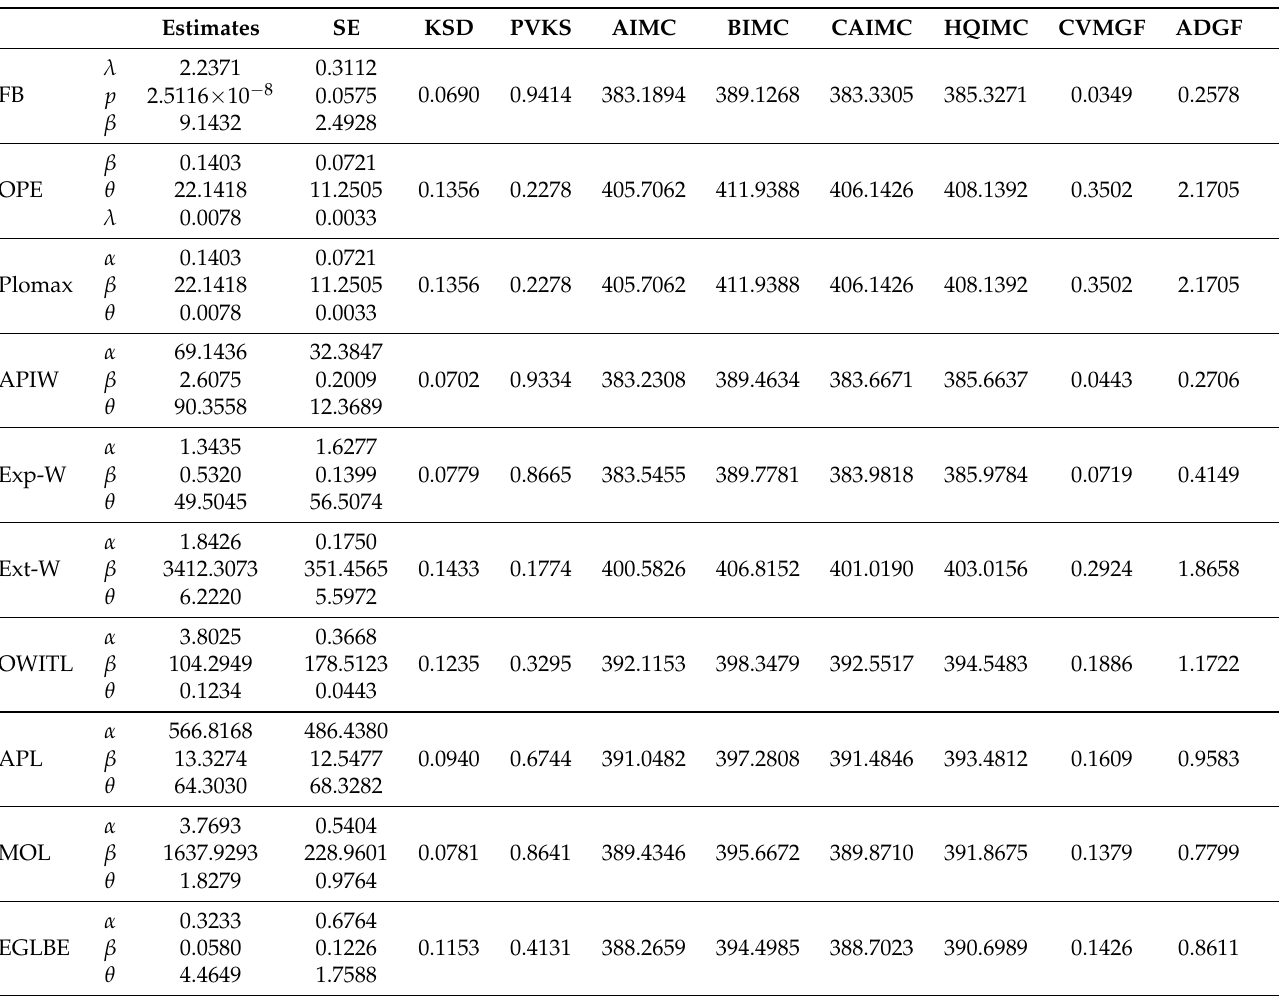
Table 14. MLE with SE and GF measures with different criteria for second set of